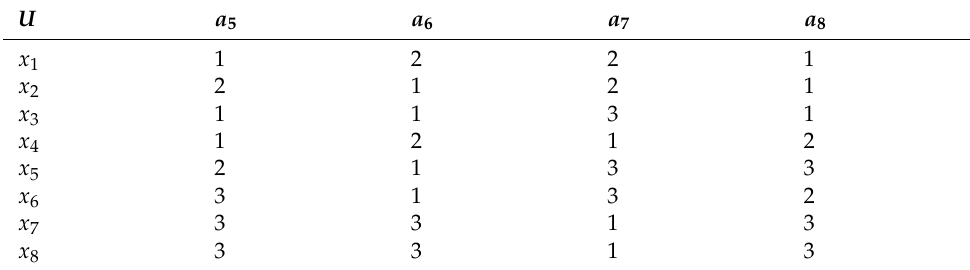
Table 2. A description of added candidate granular